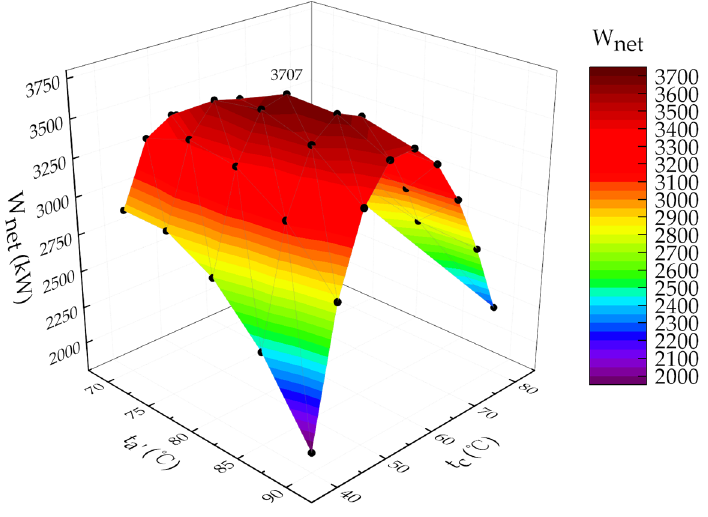
Figure 7. Influence of t a’ and t c on net output power of SFD-ORC.